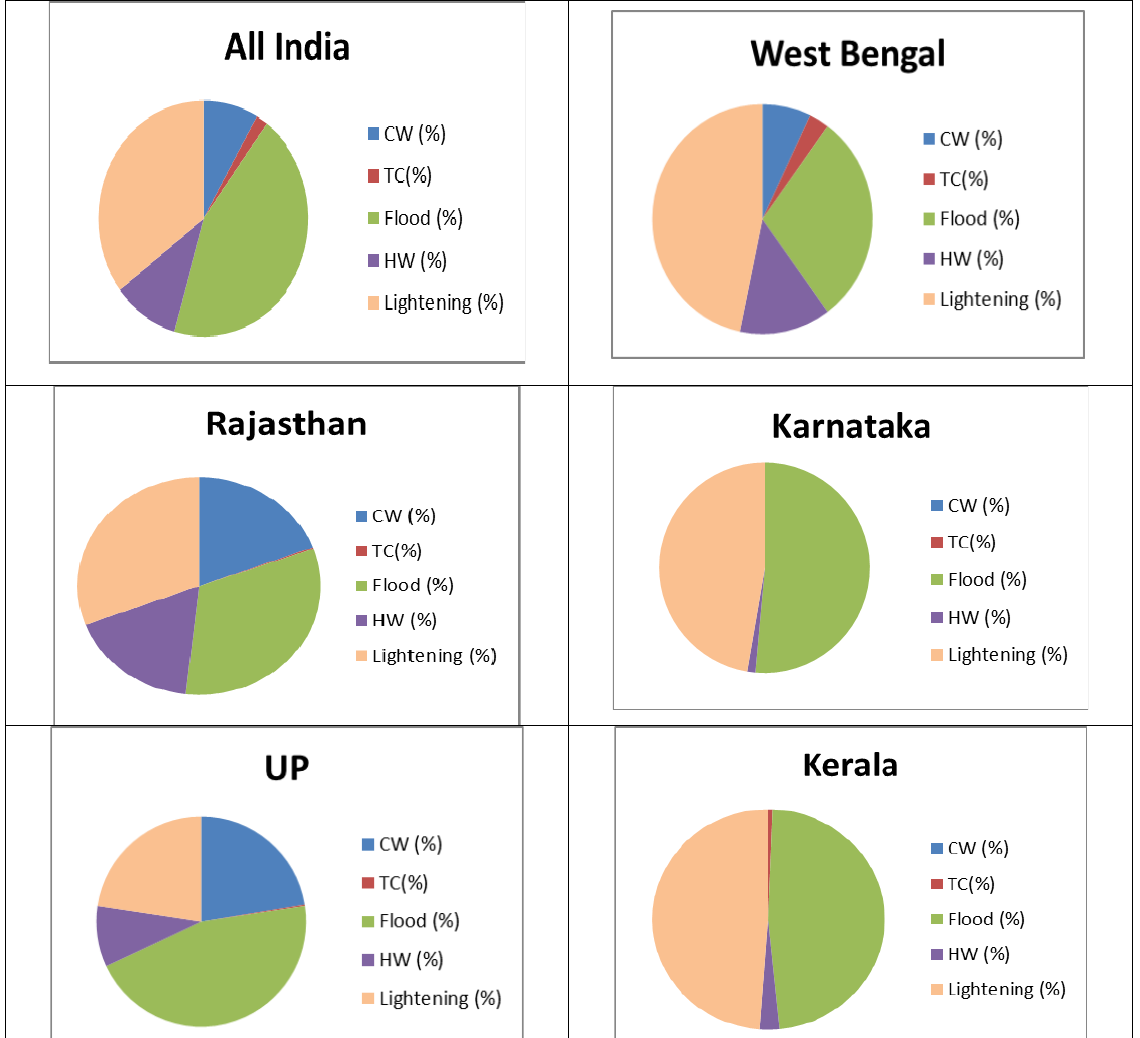
Figure 6 Percentage Frequency of various extreme weather events (Cold Wave CW: Tropical Cyclone TC: Heat Wave